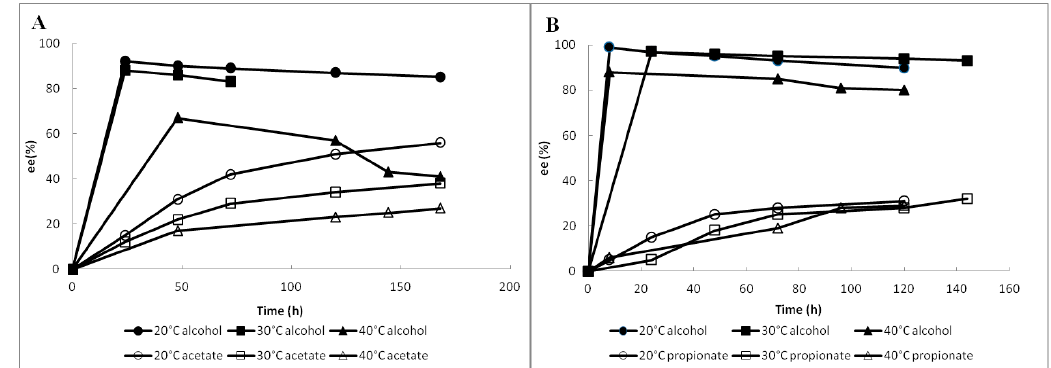
Figure 2. Effect of temperature on the enantiomeric excess of the products during Lecitase ® Ultra-catalyzed hydrolysis of acetate 4a ( A ) and propionate 4b ( B ).